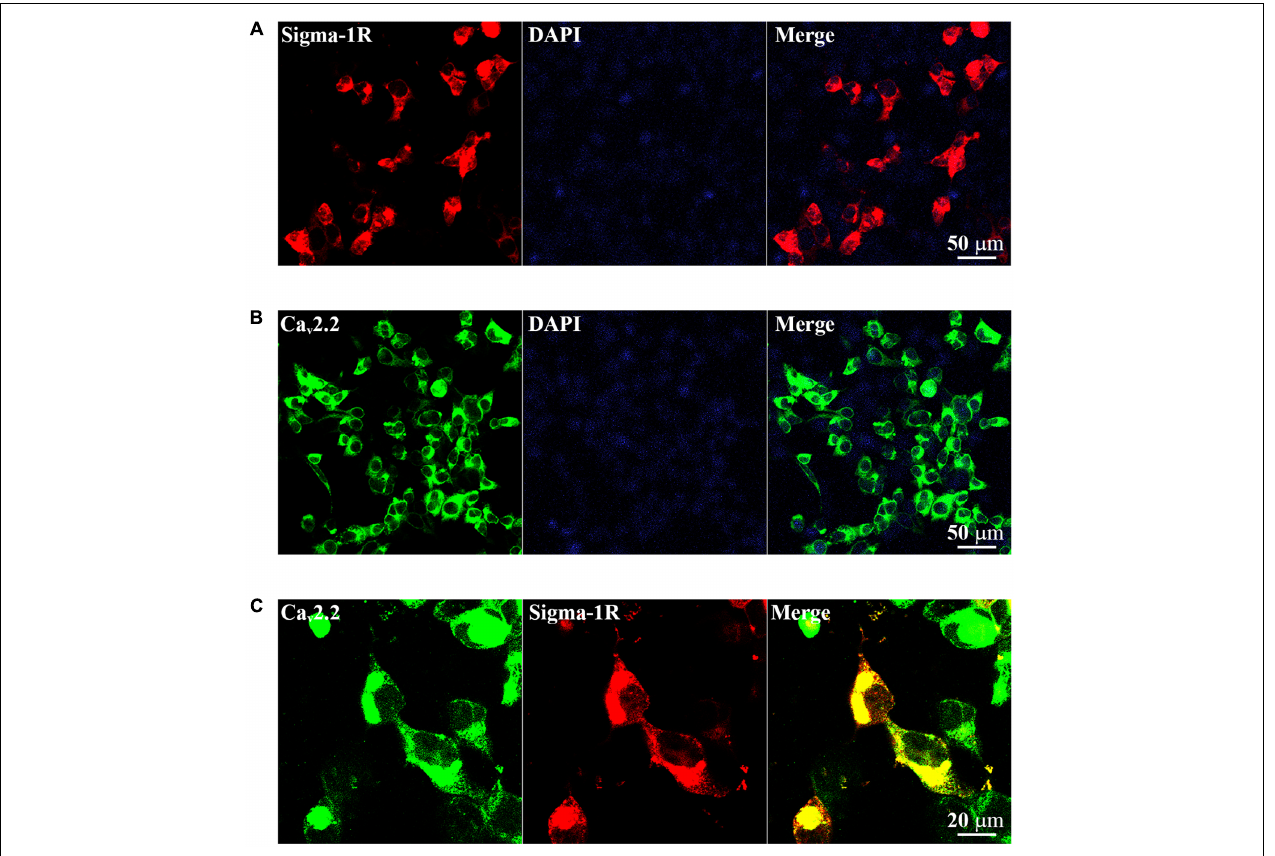
FIGURE 6 | Exogenous expression of Sigma-1-Dsred receptor and Ca v 2.2-GFP in HEK-293T cell line. (A) Fluorescence images of HEK-293T cells transfected with 0.5 µ g Sigma-1-Dsred receptor cDNA. (B) Fluorescence images of HEK-293T cells transfected with 0.5 µ g Ca v 2.2-GFP ( α 1b+ β 1b+ α 2 δ 1subunits) cDNA. (C) Confocal microscopy images of HEK-293T cells with both 0.5 µ g Ca v 2.2-GFP and 0.5 µ g Sigma-1-Dsred receptor cDNA. Co-localization was shown in